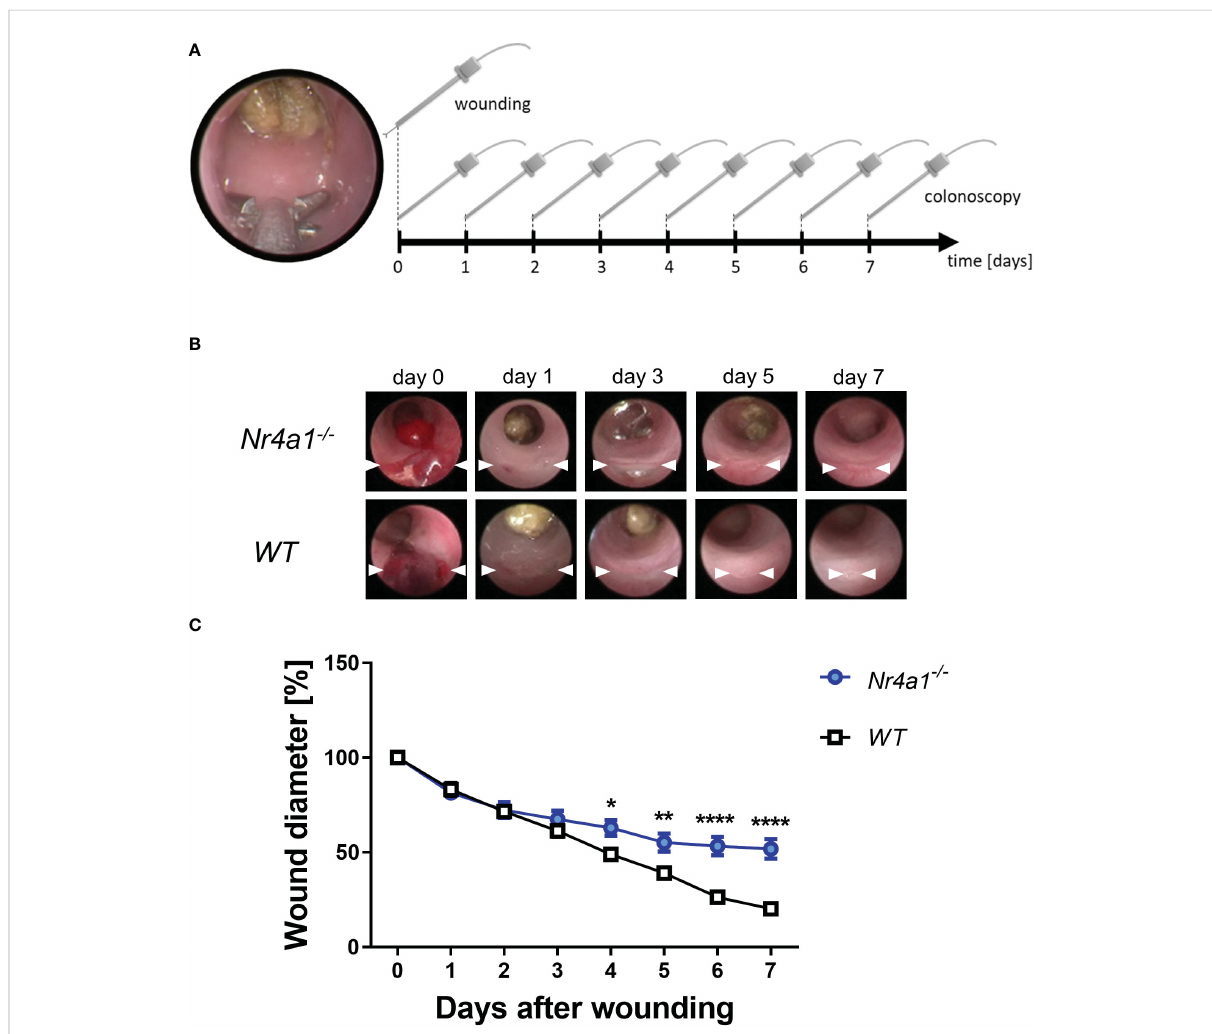
FIGURE 3 Delayed wound healing in the colon of Nr4a1 -/- mice. (A) Schematic depiction of the in vivo wound healing model. The intestinal mucosal wounds were in fl icted with a biopsy forceps (day 0) and subsequently followed up by endoscopy (day 0-7). (B) Representative colonoscopy images of large intestinal wounds in the descending colon at the indicated time points. (C) Quantitative analysis of relative wound diameters over time (n=8-9 per group). The indicated wound diameters were related to the initial wound diameter on day 0. * p < 0.05, ** p < 0.01, **** p <